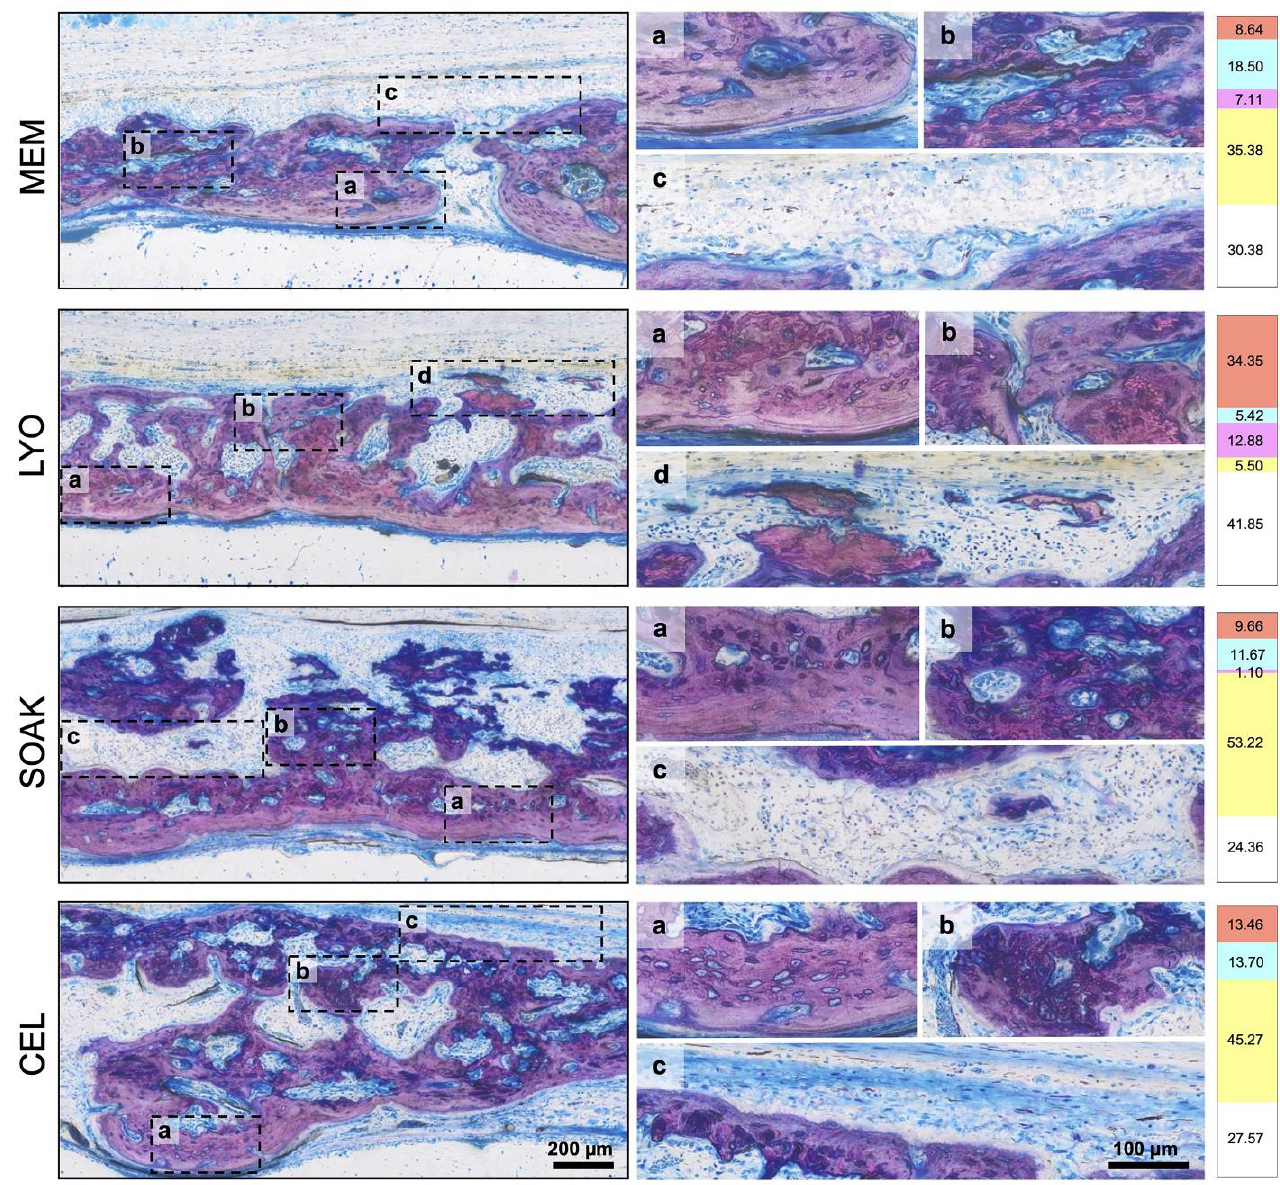
Figure 5. Histological analysis (continued). Representative histological images at higher magnification showing the different analyzed tissues in the experimental groups. The left panel shows a region of interest in each group with outlined sub-regions, which are enlarged in the right panel (scale bars: left panel 200 μ m; right panel 100 μ m). Each sub-region shows a specific tissue type indicated by letters (a – d). Numbers in the far right panel indicate relative percentages of tissue area in each group (for the whole group) based on color coding. Letters and colors indicate each tissue type: new bone (a, red), hybrid bone (b, cyan), residual membrane (c, yellow) and mineralized fibers (d, pink). White color in the far right panel indicates soft tissue areas.